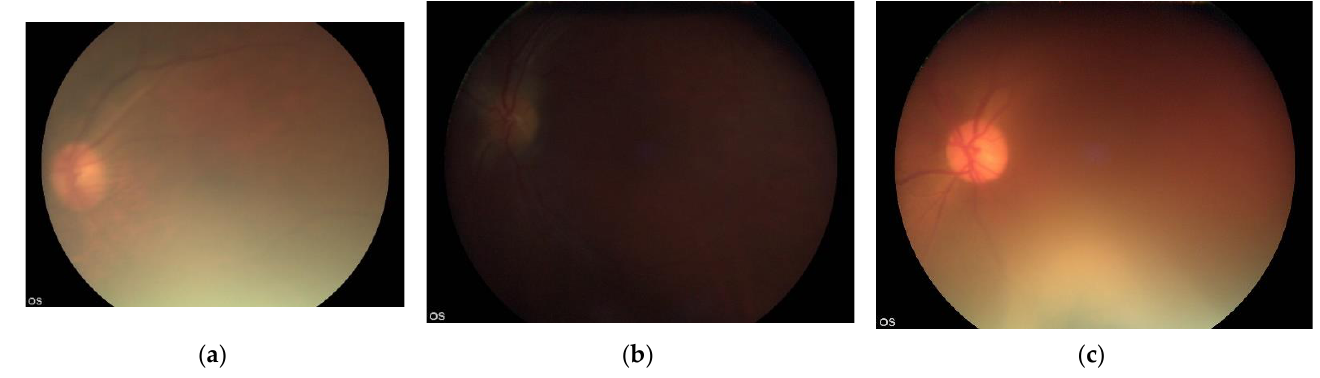
Figure 1. Image examples of disagreement. ( a ) Primary grader: ungradable, secondary grader: